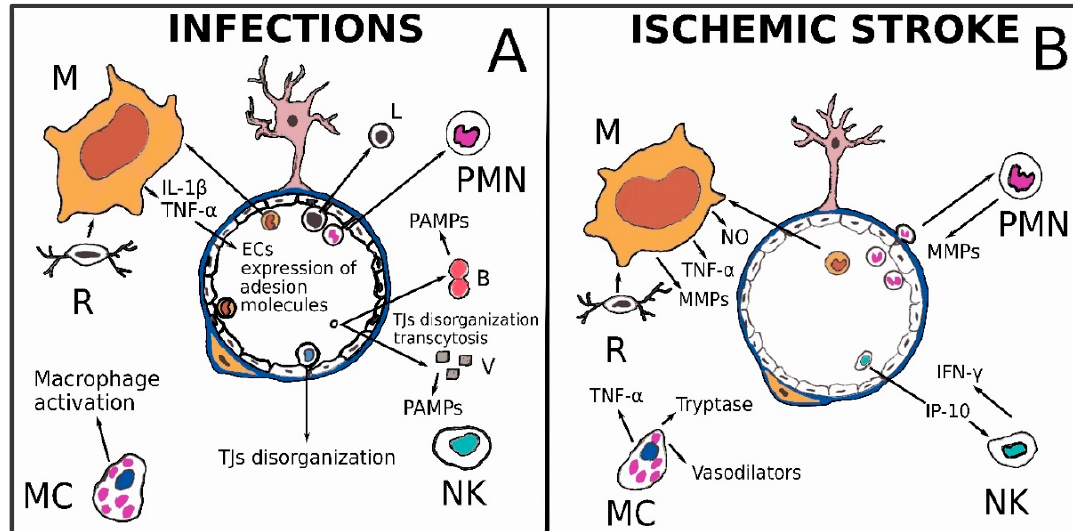
Figure 2. ( A ) Infectious agents can destroy or displace TJs’ constituent proteins or cross the BBB, also through the initiation of caveolin-dependent endocytosis mechanisms. Once pathogens have entered the nervous system, they are able to stimulate innate immunity cells through their PRRs. Cytokines such as tumor necrosis factor- α and interleukin-1 β are secreted in the inflammatory environment and stimulate ECs belonging to the BBB to upregulate cell adhesion molecules like VCAM-1, ICAM-1 and E-selectin, allowing new immune cells to enter the nervous tissue. Other immune cells, such as lymphocytes and NK cells, can disarrange the TJs’ structure and increase vessel permeability. Mast cells releasing mediators such as histamine, tryptase or CCL5, represents another possible way of macrophage activation; ( B ) Microglia (R) is rapidly activated after the ischemic event and releases mediators such as TNF- α , superoxide anion and NO, able to recruit circulating monocytes. Microglia and macrophages (M) show a pro-inflammatory activation pattern and produce molecules involved in oxidative damage and metalloproteinases (MMPs) that cause BBB leakage. After prolonged ischemia, Polymorphonuclear Neutrophils (PMNs) can be found in infarcted parenchyma. PMNs share with macrophages and microglia the ability to produce various molecules, such as MMPs, detrimental for BBB. Mast cells (MCs) degranulate after stroke and secrete compounds capable of increasing vascular permeability. NK cells are active during the acute phase of ischemic stroke. NK cells, in cerebral ischemia, promote neural cells necrosis and damage of BBB via IFN- γ . Moreover, cytokines such as IP-10 secreted by CXCR3-activated NK cells, (a chemokine of the CXC subfamily) intensify injury to the BBB. Indeed, IP-10 expression (detectable in ischemic brain tissue) may induce NK cell infiltration following cerebral